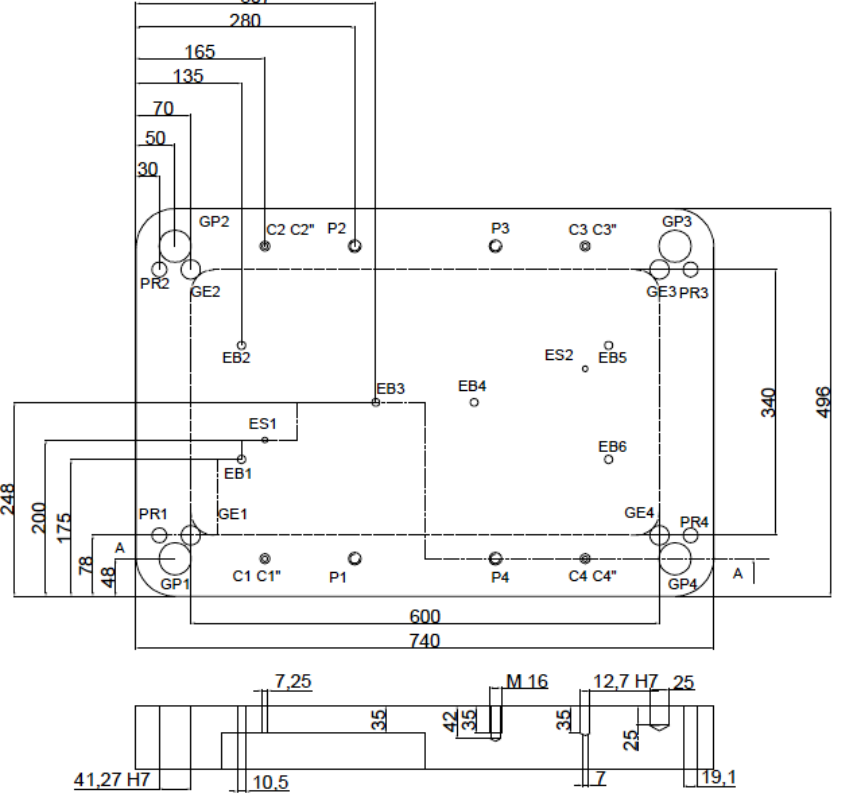
Fig. 2. Upper holder of the plastic injection